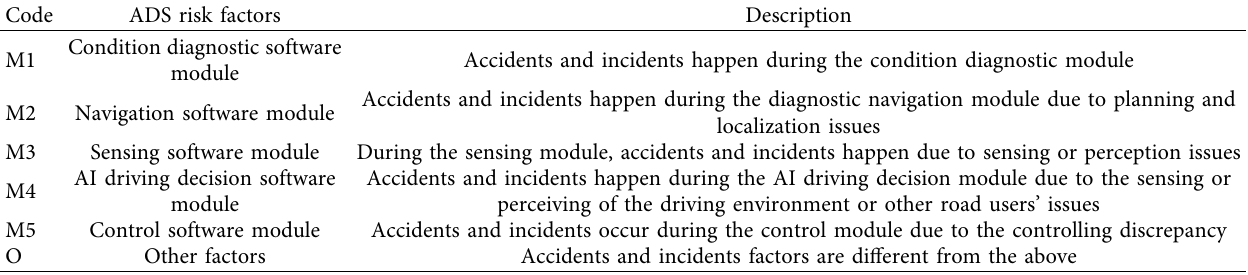
Table 5: Defnitions and descriptions of ADS software module risk factors.